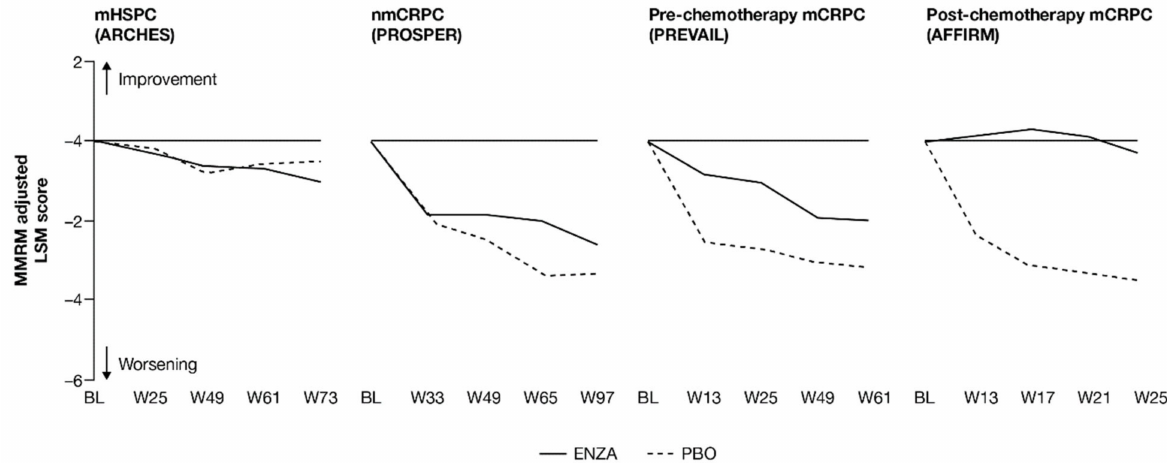
Figure 3. Adjusted change from baseline in FACT-P PCS score. ENZA indicated by solid line, and control group in- dicated by dashed line. Abbreviations: BL: Baseline; ENZA: Enzalutamide; FACT-P: Functional Assessment of Cancer Therapy—Prostate; LSM: Least squares mean; mCRPC: Metastatic castration-resistant prostate cancer; mHSPC: Metastatic hormone-sensitive prostate cancer; MMRM: Mixed-model repeated measure; nmCRPC: Non-metastatic castration-resistant prostate cancer; PBO: Placebo; PCS: Prostate Cancer Subscale of the FACT-P; W: Week.